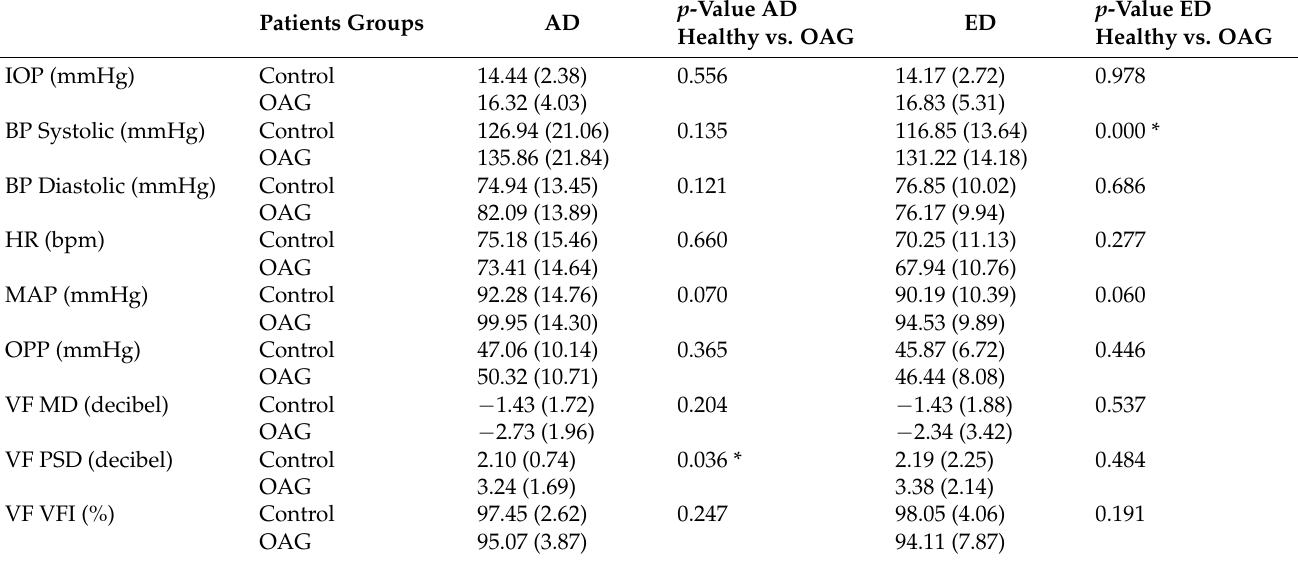
Table 1. Mean and standard deviation of ocular and systemic parameters in control and open- angle glaucoma (OAG) patients of African descent (AD) and European descent (ED). Comparisons ( p -values) between outcomes were adjusted for age, diabetes status and BP. BP: blood pressure; bpm: beats per minute; HR: heart rate; IOP: intraocular pressure; MAP: mean arterial pressure; MD: mean deviation; OPP: ocular perfusion pressure; PSD: pattern standard deviation; VF: visual field; VFI: visual field index. * p <